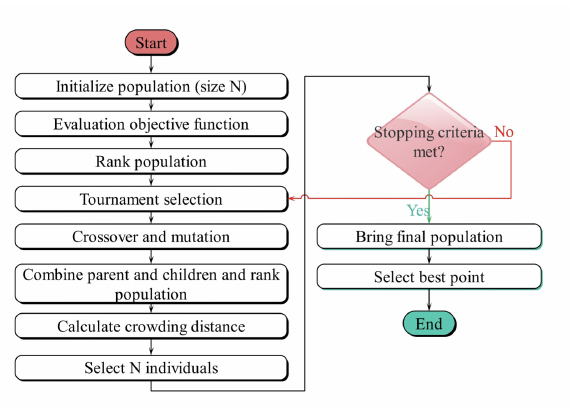
Fig. 5. The flowchart of the GA algorithm the center of the base function in the hidden layer. Also, w 0 , w 1 , . . . , w q depicts the weights in which w 0 represents the output layer weight. The Gaussian function ( φ ) used in